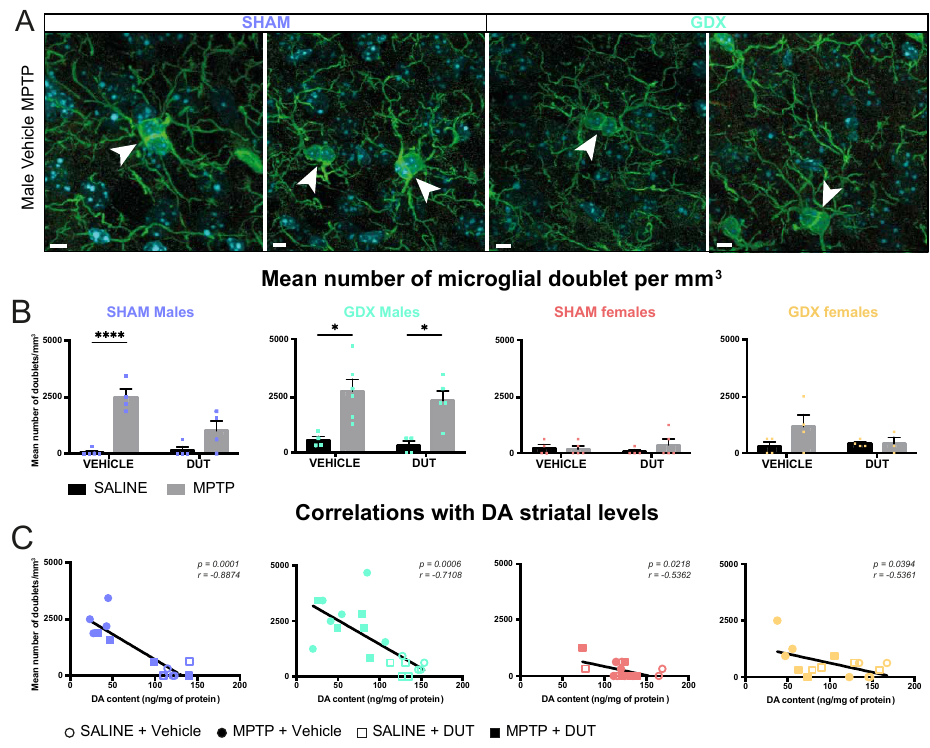
Figure 3. Effect of mice gonadal status (SHAM, GDX), MPTP, and dutasteride (DUT) treatment on striatal microglial doublet. ( A ) Representative example of striatal microglial doublet indicated with white arrowheads. Scale bars = 5 μ m; ( B ) Microglial doublet counts in the striatum in SHAM and GDX males and SHAM and GDX female mice. Values shown are the mean number of doublets per image ± SEM 4 images of 4-6 mice per group and from 0 to 4 microglial doublet per image. Two- way ANOVA, Tukey post-hoc test: * p < 0.05 and **** p < 0.0001 and ( C ) Correlations between striatal